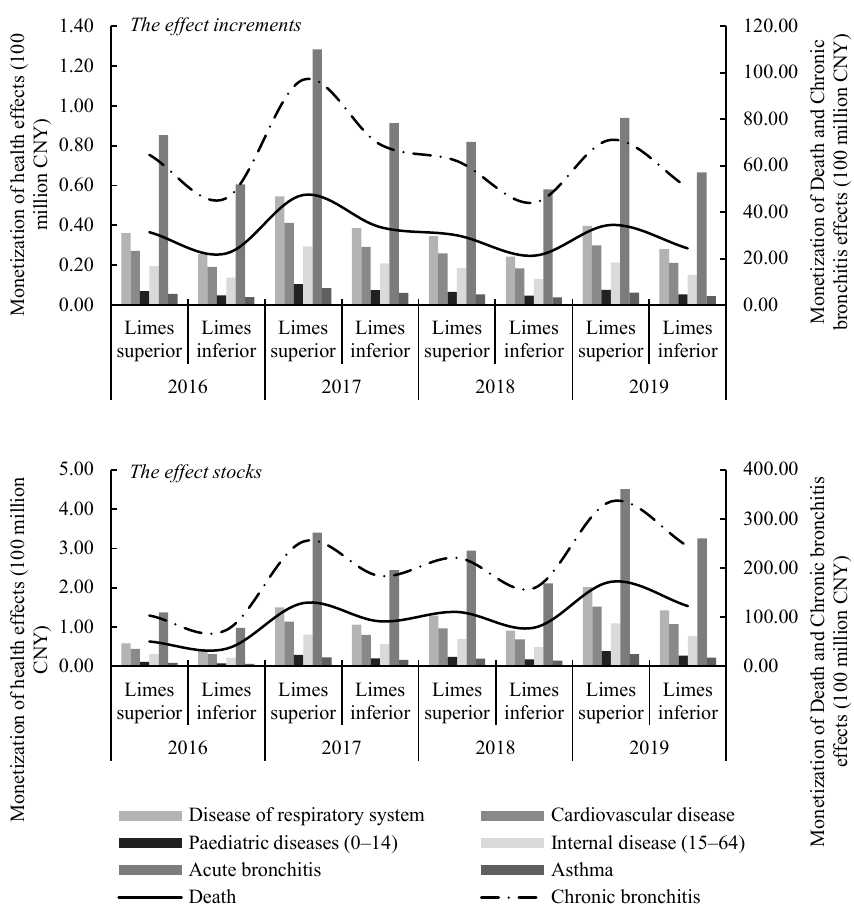
Figure 6. Monetization of NEV promotion effects in Beijing from 2016 to 2019.